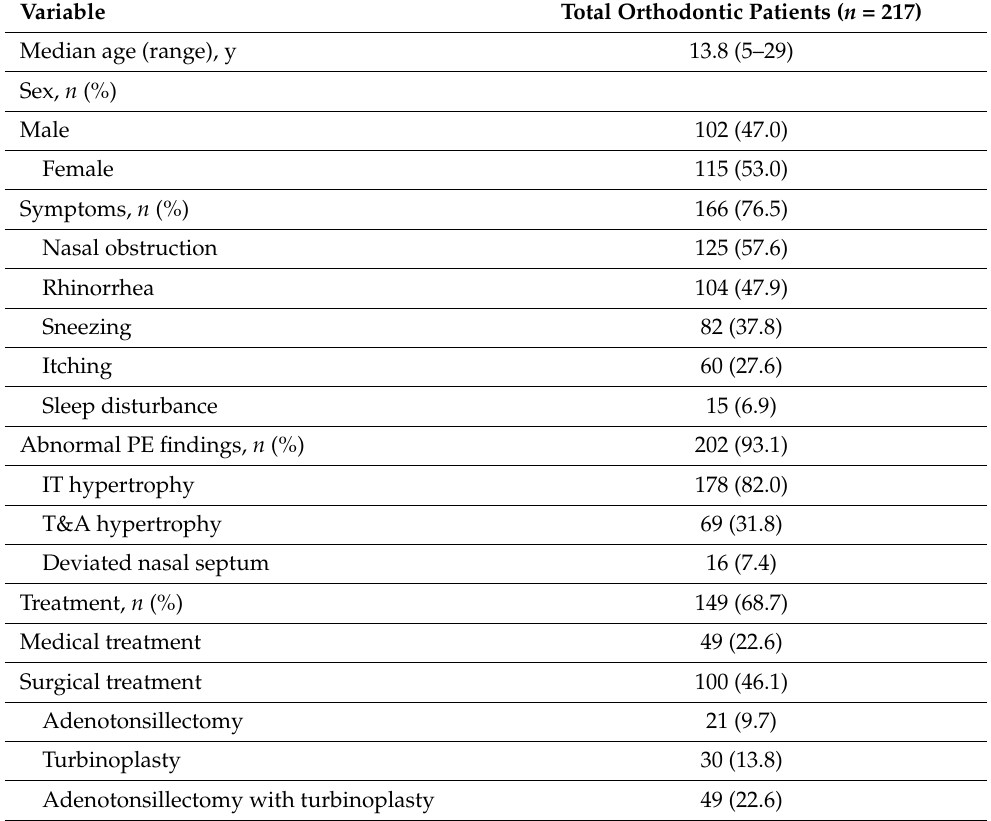
Table 1. Demographic and clinical characteristics of patients.